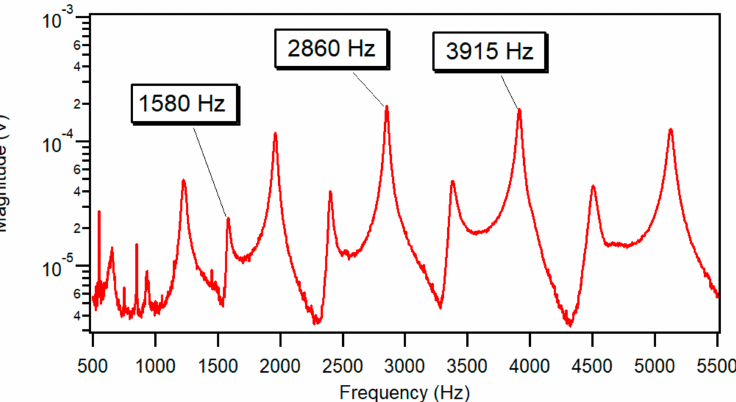
Figure 3. Frequency Response Function of the composite beam measured at sensor S1.